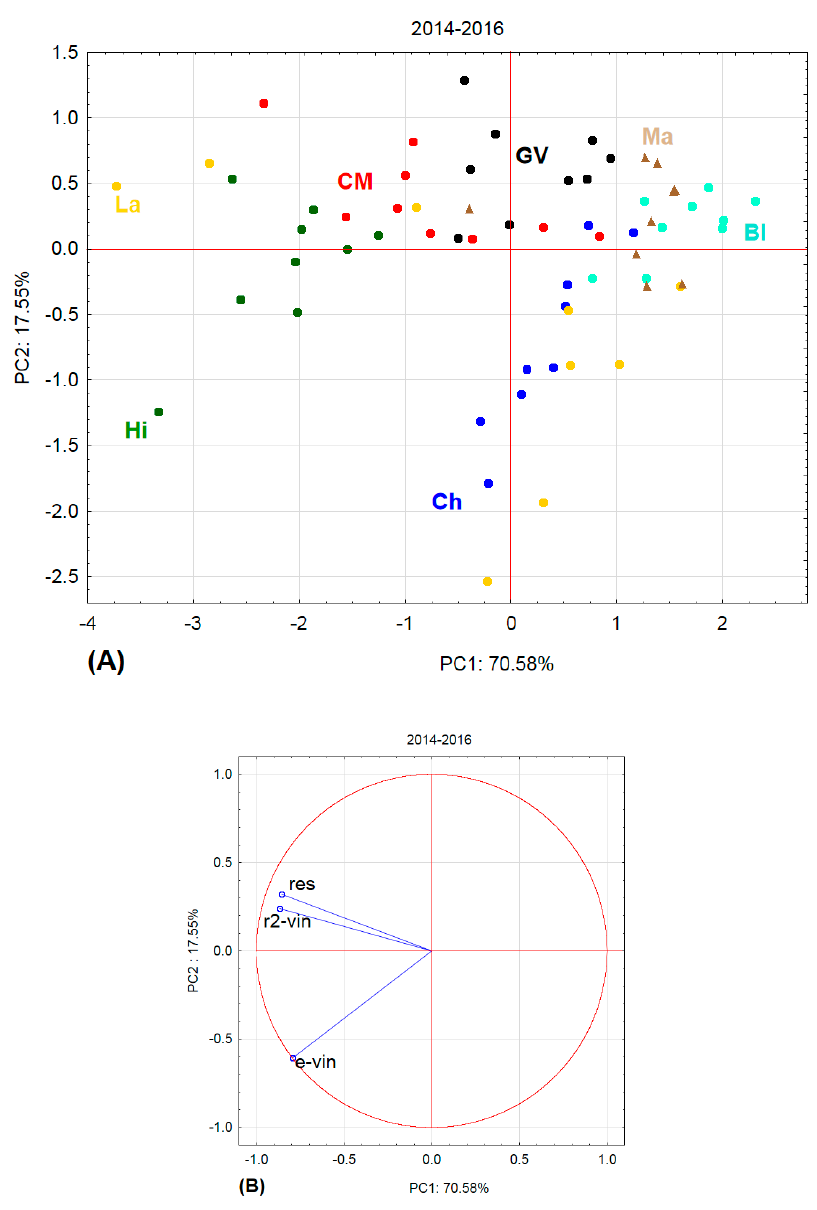
Figure 8. Principal component analysis for all three years. ( A ) projection of varieties and localities into component plane; ( B ) projection of component weights of stilbenes.